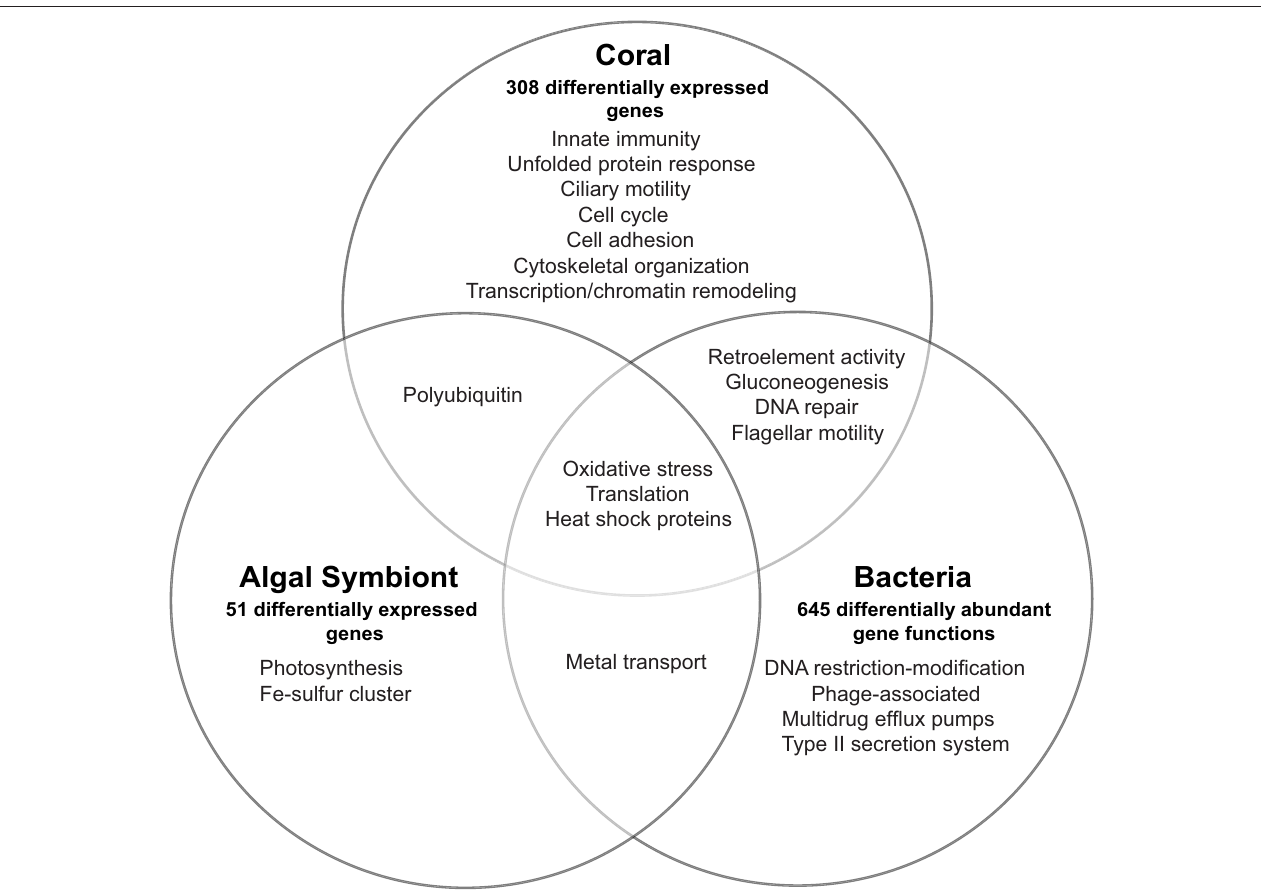
FIGURE 1 | Overview of transcriptional response and affected biological processes in the Orbicella faveolata coral holobiont in White Plague Disease. The number of differentially expressed eukaryotic and differentially abundant bacterial genes are shown for each holobiont compartment.